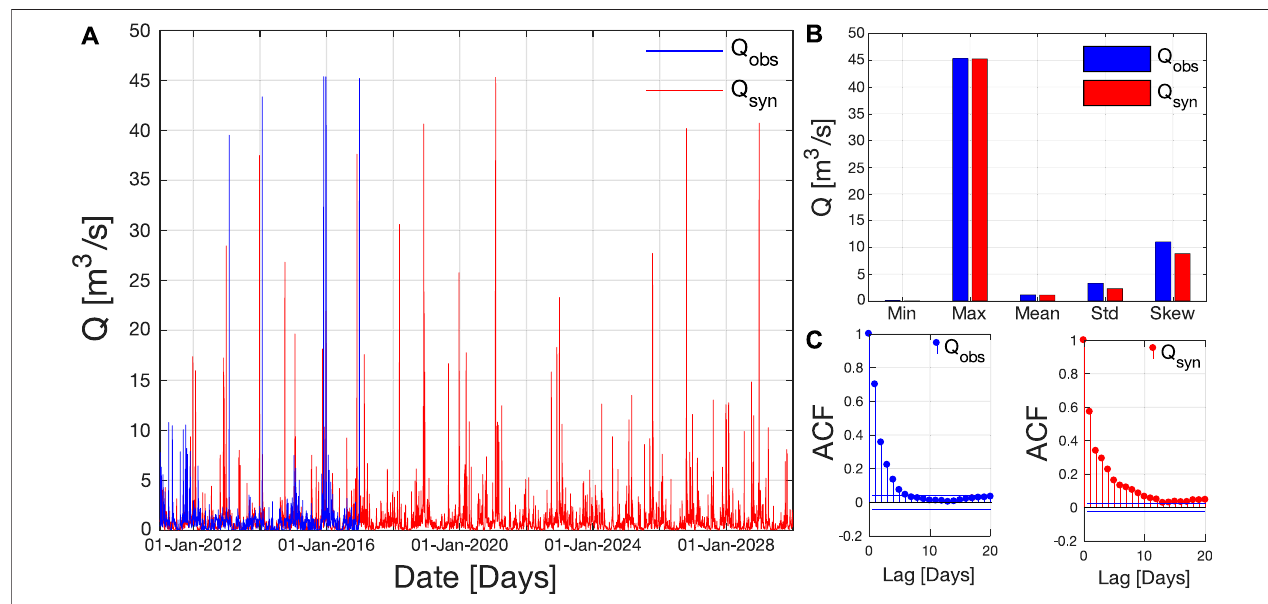
FIGURE 3 | (A) Example of synthetic 20-y hydrograph obtained with the back- fi ltered PAR model based on the 5-y hydrograph for the Inverliever SHP. (B) Comparison of some statistical quantities for the observed and synthetic hydrographs. (C) Comparison of the autocorrelation function of the observed and synthetic